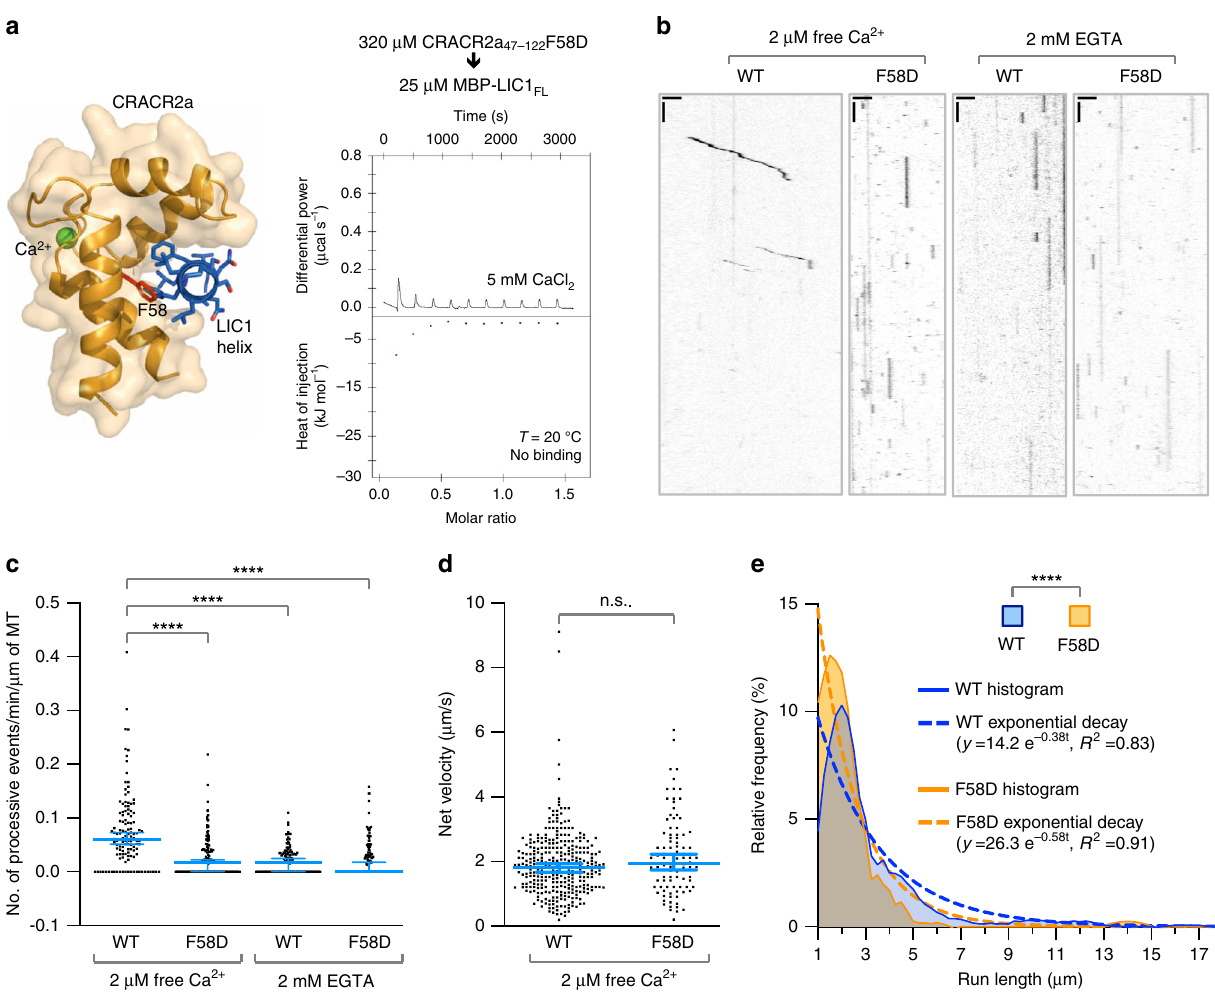
Fig. 5 Disrupting the CRACR2a – LIC1 interaction impairs dynein motility. a Mutating residues F58 (red) in the hydrophobic cleft of CRACR2a (orange) that bids the LIC1 helix (blue) to aspartic acid inhibits this interaction, as revealed by the ITC titration of CRACR2a 47 – 122 F58D into MBP-LIC FL (experimental conditions given in the fi gure). The lack of change in the heat of injection precludes fi tting to a binding isotherm. b Representative kymographs of the dynein – dynactin driven motility of single Halo-CRACR2a-positive particles (WT and mutant F58D CRACR2a) analyzed by TIRF microscopy with either 2 µ M free Ca 2 + (left) or 2 mM EGTA (right). Kymographs are oriented with the + end of the microtubule (MT) on the left (scale bars: horizontal, 3 µ m; vertical, 5 s). c Quantitative analysis of the number of processive motile events, de fi ned as runs of ≥ 1 µ m, observed under the conditions shown in part b of this fi gure. Each point represents a single microtubule ( n = 123 per condition). The statistical signi fi cance of the measurements was determined using the Kruskal – Wallis test, followed by a Dunn ’ s multiple comparisons test. Bars represent the median and 95% con fi dence interval. d Velocities of WT or mutant F58D CRACR2a with 2 µ M free Ca 2 + , statistically analyzed using an unpaired t test and two-tailed p values were calculated. Data is pooled from three replicates (WT n = 326; F58D n = 95). Bars represent the median and 95% con fi dence interval; p = 0.0579. e Histogram of run lengths for WT and mutant F58D Halo-CRACR2a-positive particles with 2 µ M free Ca 2 + . The data were analyzed using a Mann – Whitney test and two-tailed p values were calculated (**** p < 0.0001; n.s. nonsigni fi cant or p > 0.05). The data were pooled from three replicates (WT n = 317; F58D n = 87). Source data for panels b – e are provided in the Source Data fi